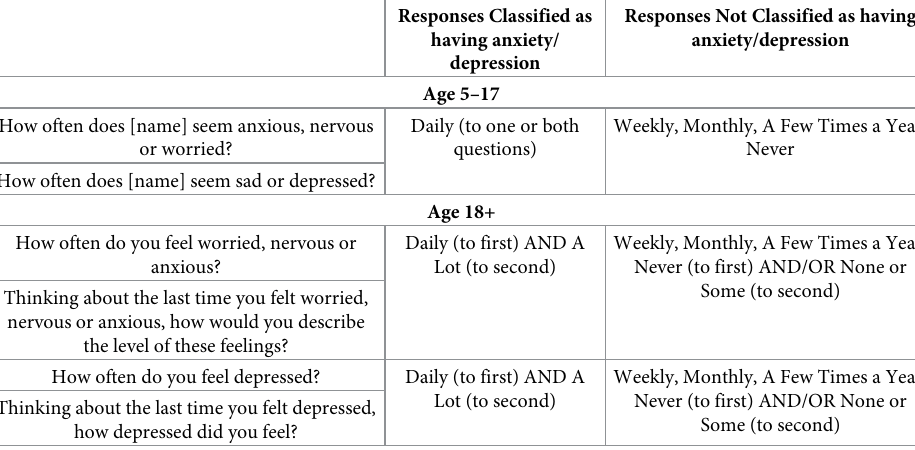
Table 1. Questions and case definitions for anxiety and